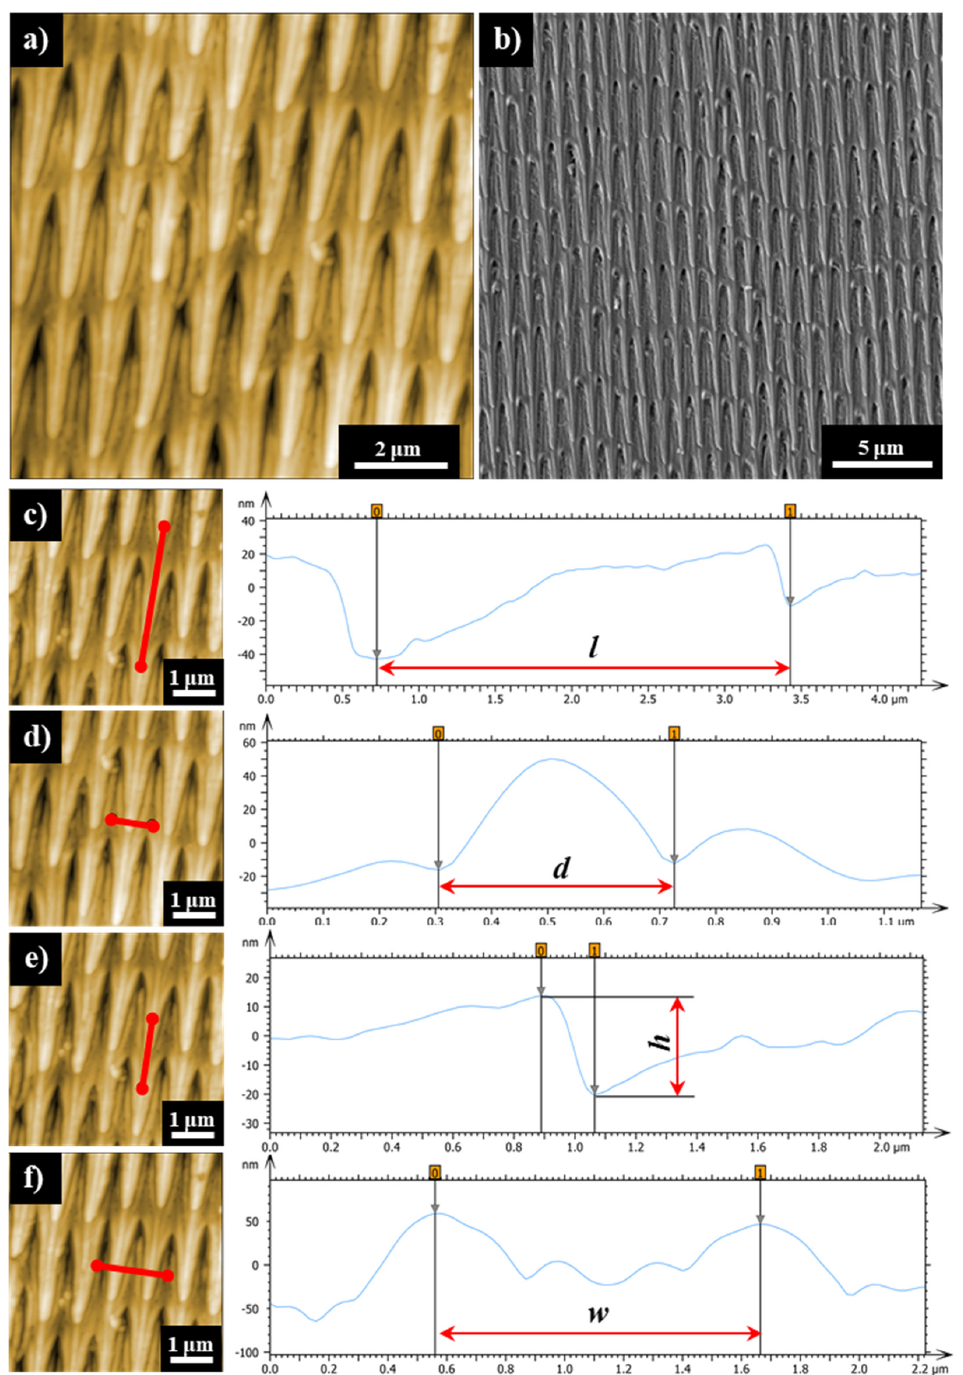
Figure 3. Microstructures of ventral scales surface and definition of micro-convex body sizes. ( a ) AFM (10 μ m × 10 μ m), ( b ) SEM (5 kV, 10,000×), ( c – f ) the dimension parameters of the ventral scale. l : the length of the ridge; d : the diameter of the microstructure end; h : the height of the microstructure end; w : the distance between two adjacent microstructures.